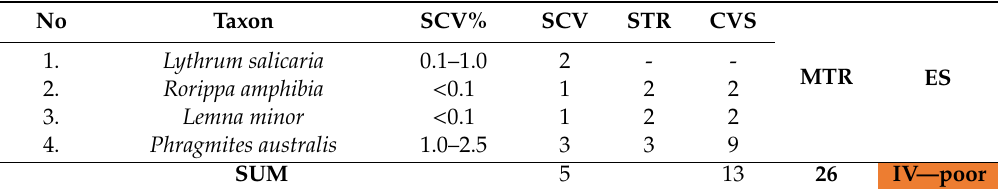
Table 10. Summary of MTR results, May 2017, section above the barrage on the ´Sl˛eza.